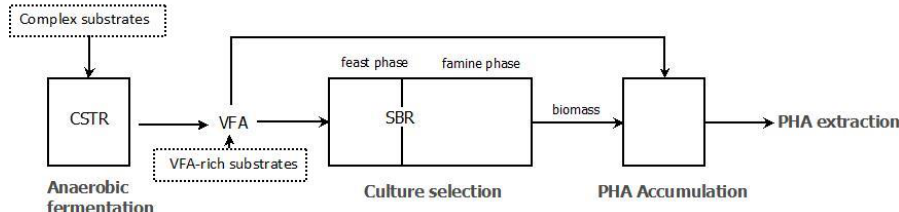
Figure 1. PHA production process by mixed microbial cultures. Modified from [88]. CSTR: continuous stirred tank reactor, SBR: Sequential Batch Reactor.